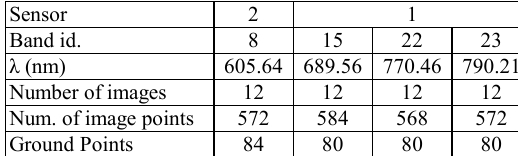
Table 4. Image bands used for terrestrial calibration and the number of images and points.